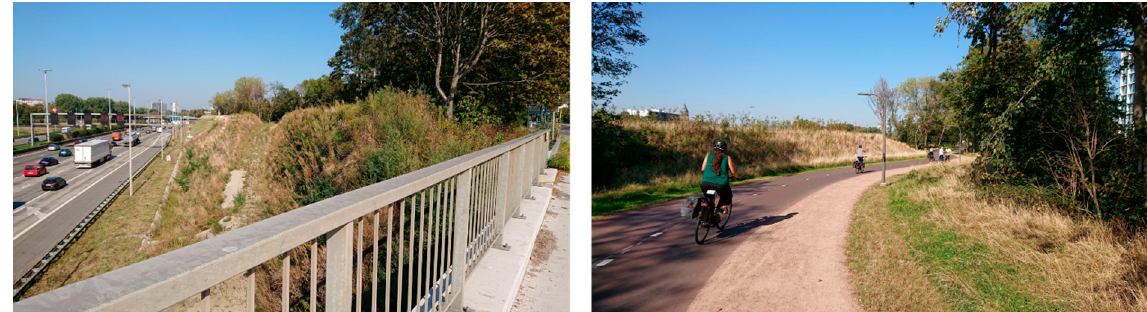
Figure 1. Photographs taken on site: a view towards the berm from the bridge ( left ), and another one along the path itself showing vegetation and the berm ( right ).